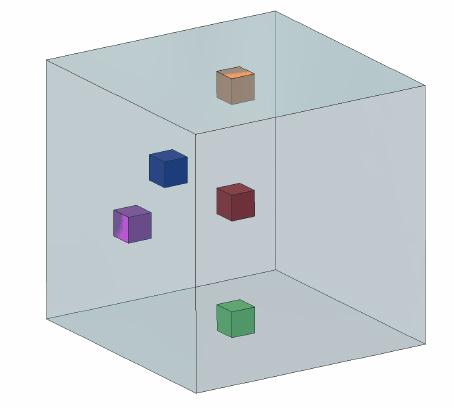
Figure A4. Figure displaying the results of chamber mixing tests, including: schematic showing 5 different node placements in the chamber, in their corresponding colours ( below ), and time-series (plots A and C) and scatter-plots (plots B and D) of two different mixing tests, where the CO 2 concentration was incrementally increased before rapidly venting the chamber ( A , B ) and slowly increased before leaving to steadily decay ( C , D